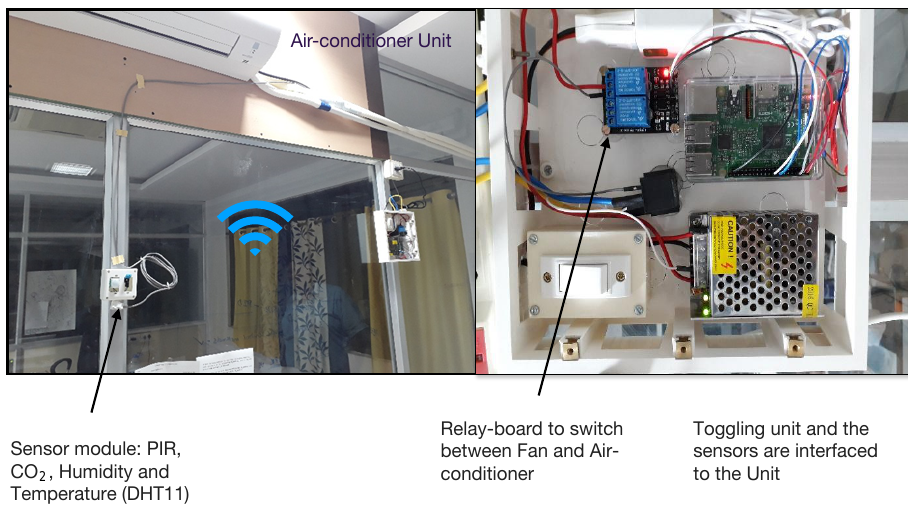
Figure 2. The sensor and controller units used for energy